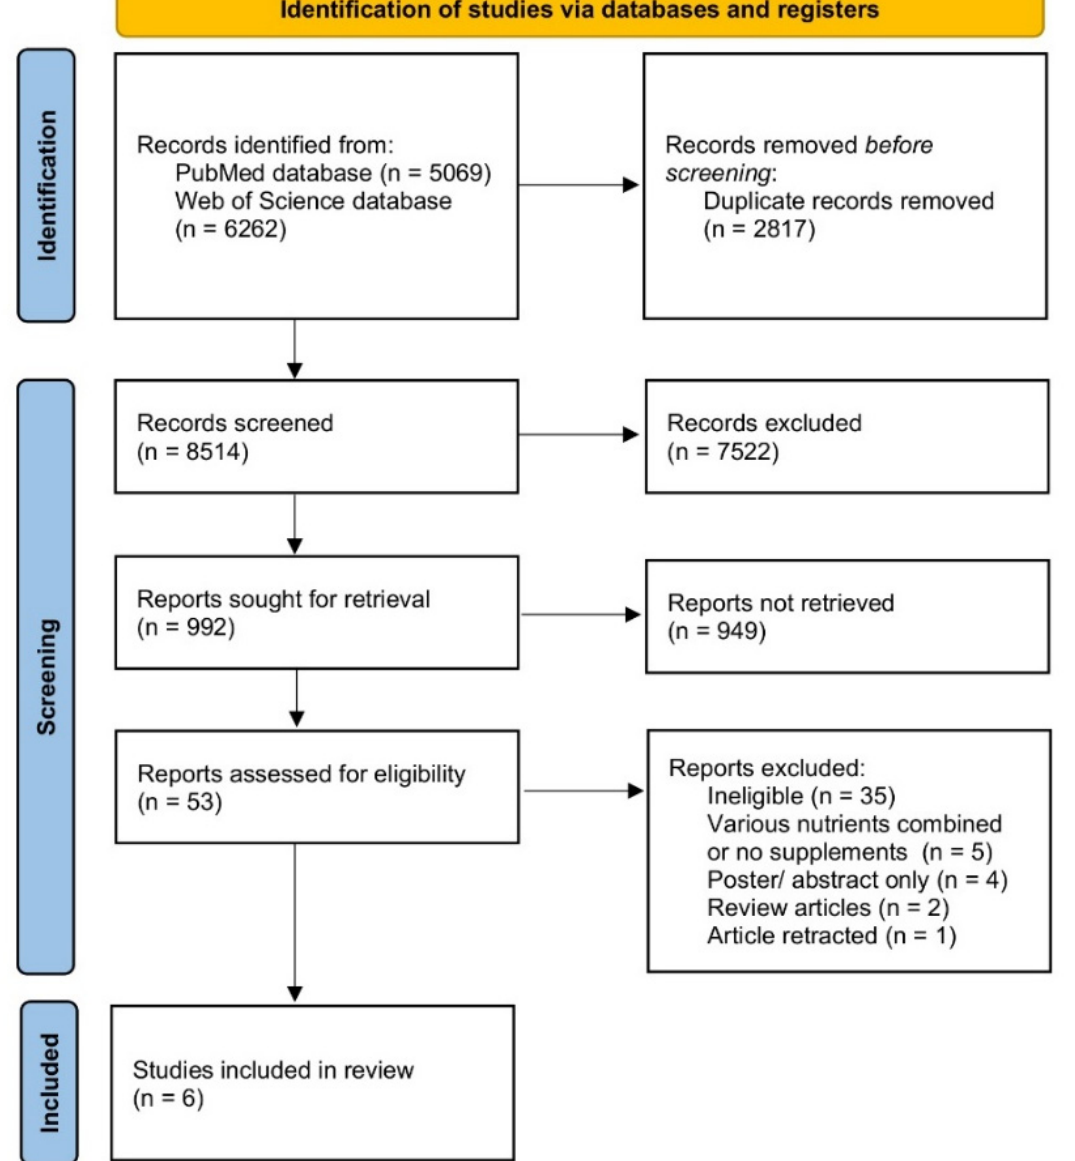
Figure 1. The procedure of identification, screening, eligibility assessment and inclusion of studies in the systematic review.